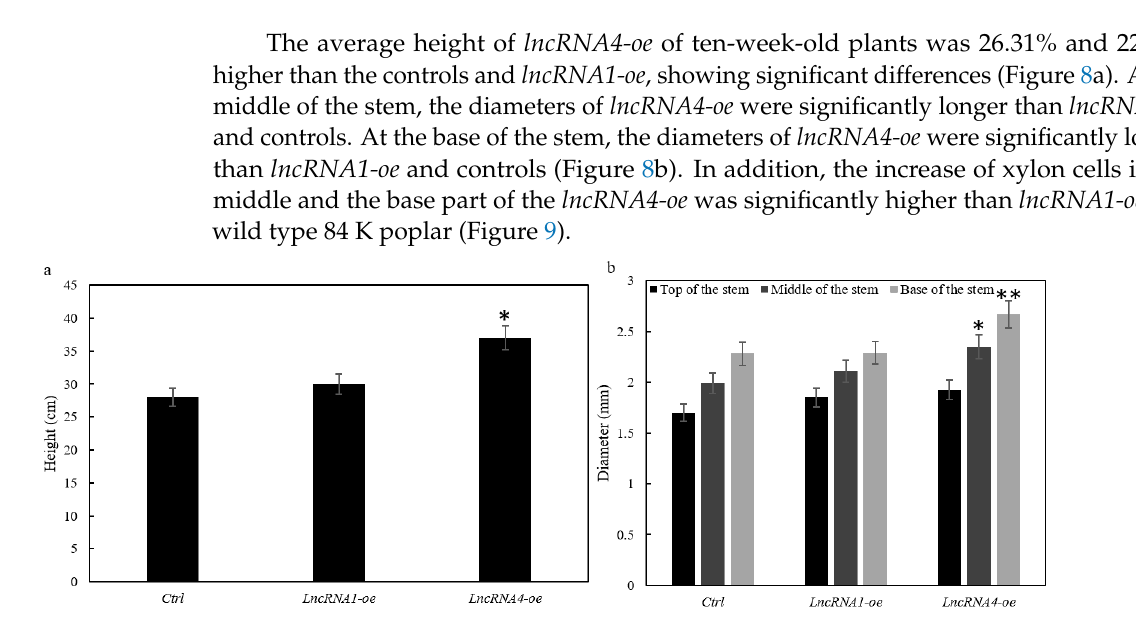
Figure 8. Statistics of plant height and internode diameter of overexpression and wild type 84K poplar trees. ( a ) represented the average plant height for ten-week-old wild type 84K, lncRNA1-oe and lncRNA4-oe . ( b ) represented the average diameter of upper, middle and basal part of stem for ten-week-old wild-type 84K, lncRNA1-oe and lncRNA4-oe plant. Bars represented standard errors (SE), * represented the significant difference ( p < 0.05), and ** represented the highly significant difference ( p < 0.01). Values were reported as means ± SE ( n = 4).